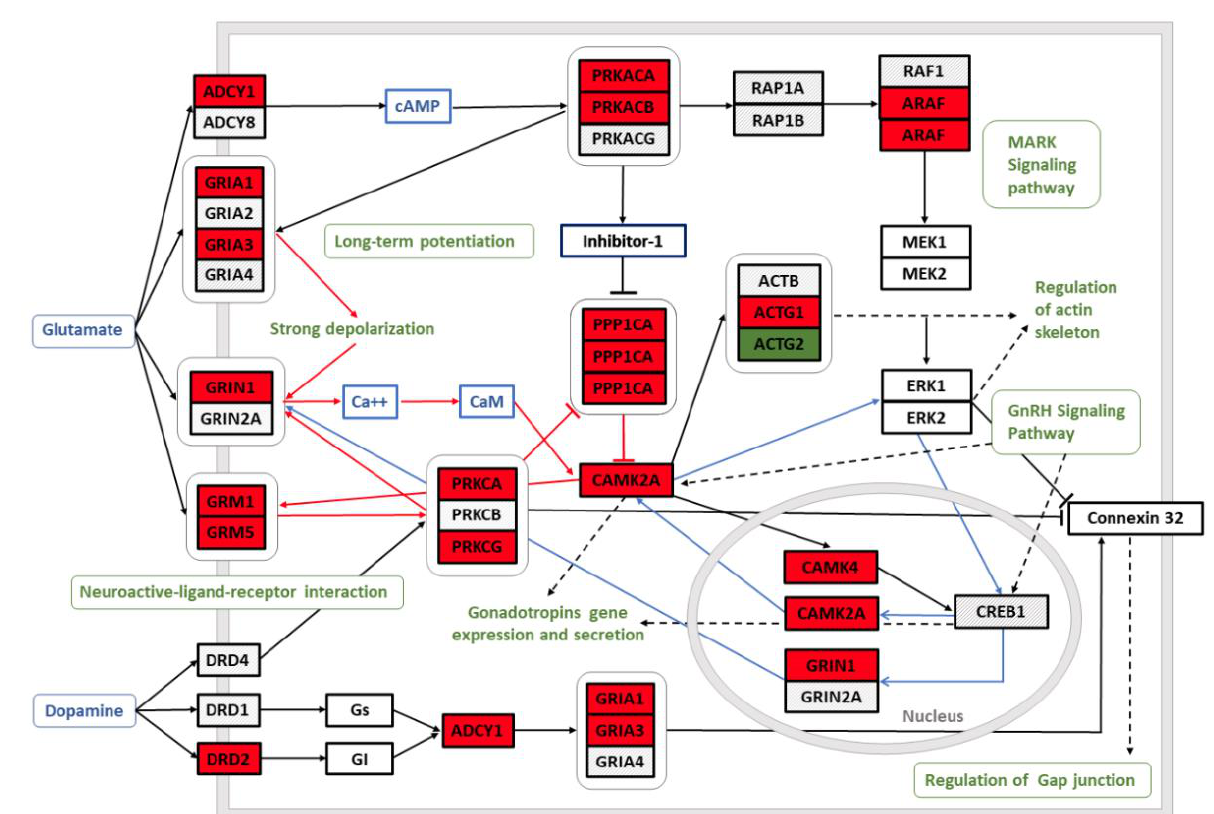
Figure 3. The schematic model of “Common Pathways Underlying Drug dependence” is an output (FDR p < 0.01) of the Wikipathway functional pathway analysis [39]. Red background of the genes indicates significant upregulation and green background downregulation of the gene in the dorsomedial thalamus of the AUD subjects. The schema is originally constructed by Li et al. [40]: glutamate and dopamine neuroactive ligand-receptor interactions trigger long-term potentiation, MAPK and GnRH signaling and gap junction regulation.